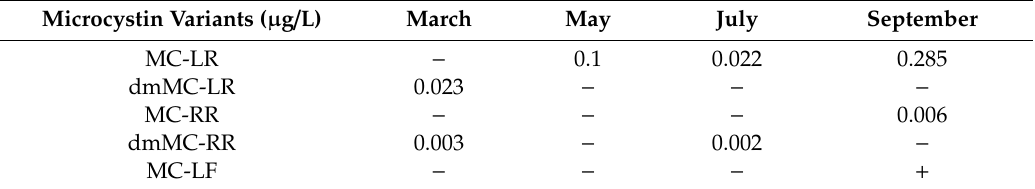
Table 5. Presence and highest concentrations of microcystin (MC) variants in Lake Ludoš during 2018. Microcystin Variants ( µ g / L)